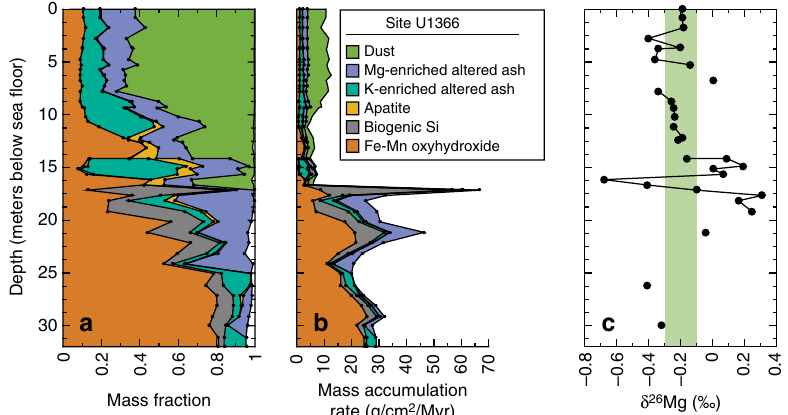
Fig. 1 End-member model and δ 26 Mg of bulk sediment at Site U1366. a Mass fractions of the six end-members that comprise the deep-sea pelagic sediment at Site U1366, as modeled with constrained least squares multiple linear regression. b Mass accumulation rates of each end-member calculated from the modeled mass fractions and total mass accumulation rates 21 . c Measured δ 26 Mg ( ‰ ) values for the same bulk sediment samples. Green vertical shading highlights the samples with δ 26 Mg values within the range of average upper continental composition (0 − 14 mbsf) and helps identify the samples with heavier δ 26 Mg (14 − 20 mbsf, to the right of the green vertical shading) caused by the incorporation of seawater Mg into authigenic